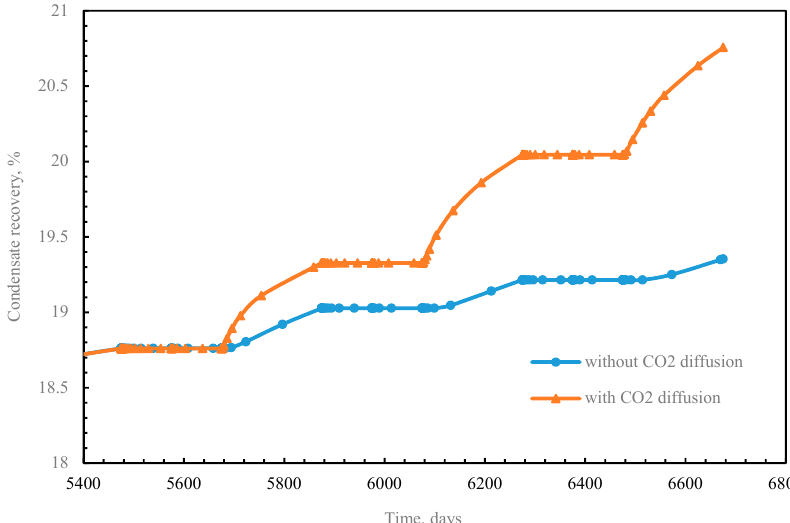
Figure 21. Cumulative condensate recovery with and without CO 2 diffusion.